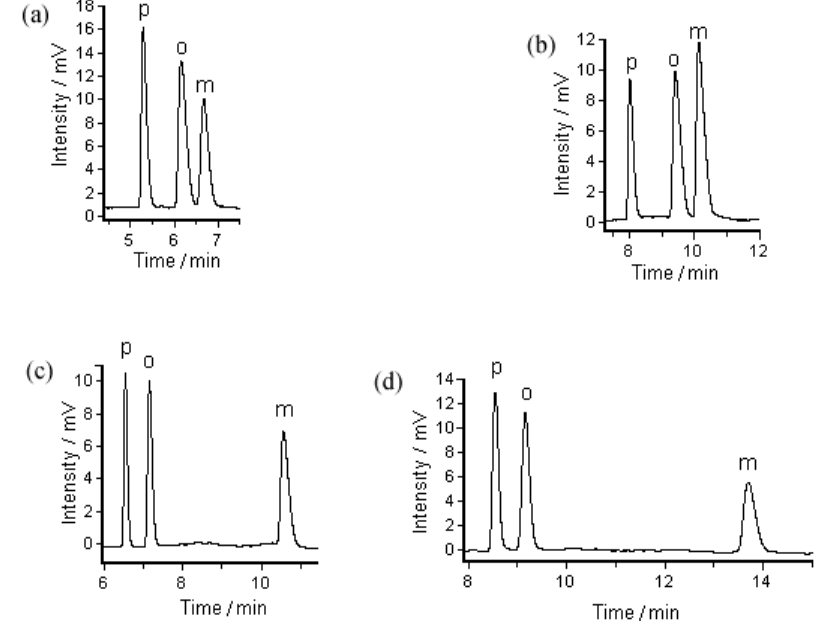
Figure 2. GC chromatograms using the pentyl cage-coated capillary column for separation of positional isomers: ( a ) o -, m -, and p -dibromobenzene under a N 2 flow rate of 13.8 cm ∙ s − 1 at 90 °C; ( b ) o -, m -, and p -dibromobenzene under a N 2 flow rate of 13.8 cm ∙ s − 1 at 110 °C; ( c ) o -, m -, and p -nitrochlorobenzene under a N 2 flow rate of 14.9 cm ∙ s − 1 at 115 °C; ( d ) o -, m -, and p -nitrobromobenzene under a N 2 flow rate of 14.9 cm ∙ s − 1 at 120 °C. Table 2. Separation factor ( α ) and resolution (Rs) for separation of positional isomers on the pentyl cage-coated capillary column.